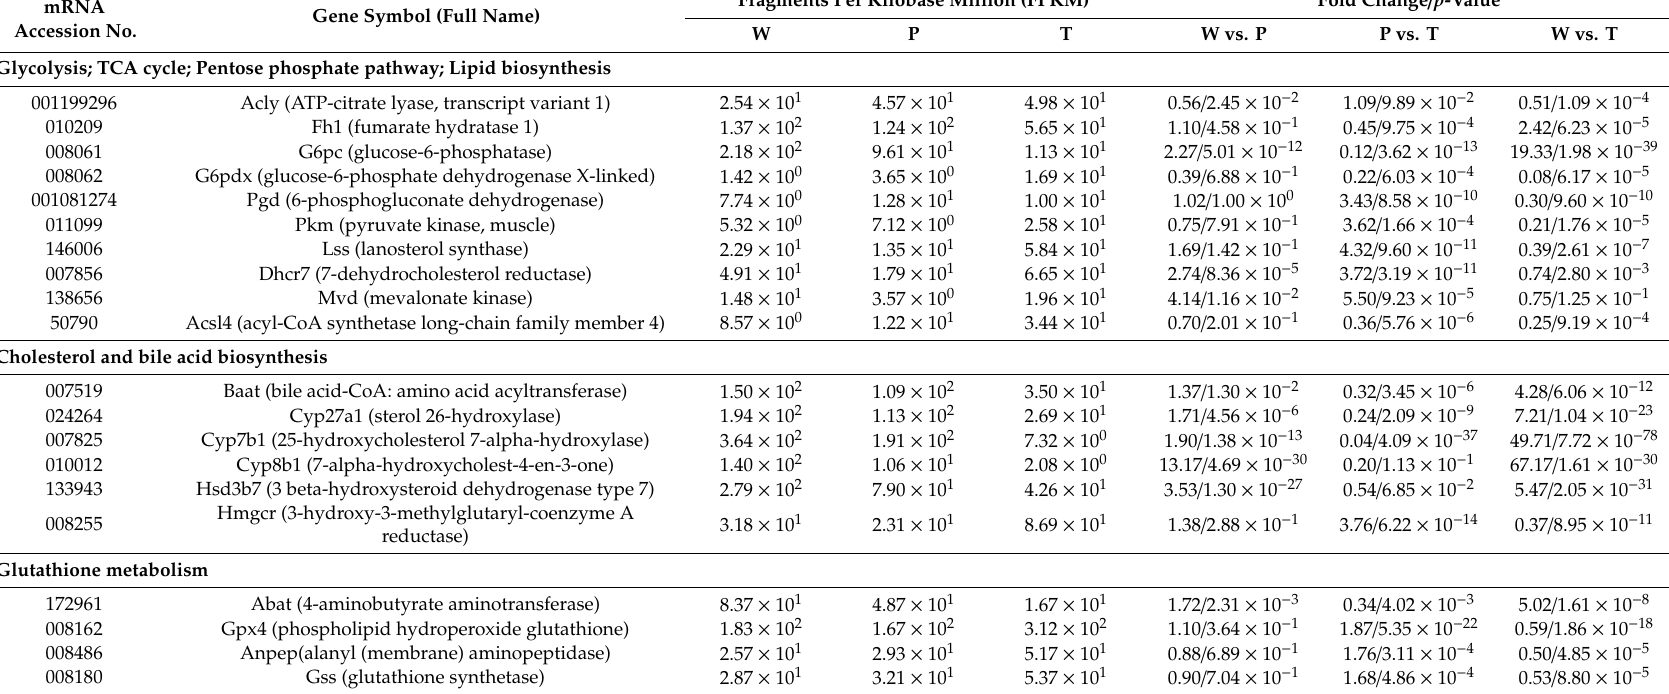
Table 2. DEGs in paired comparisons between W, P, and